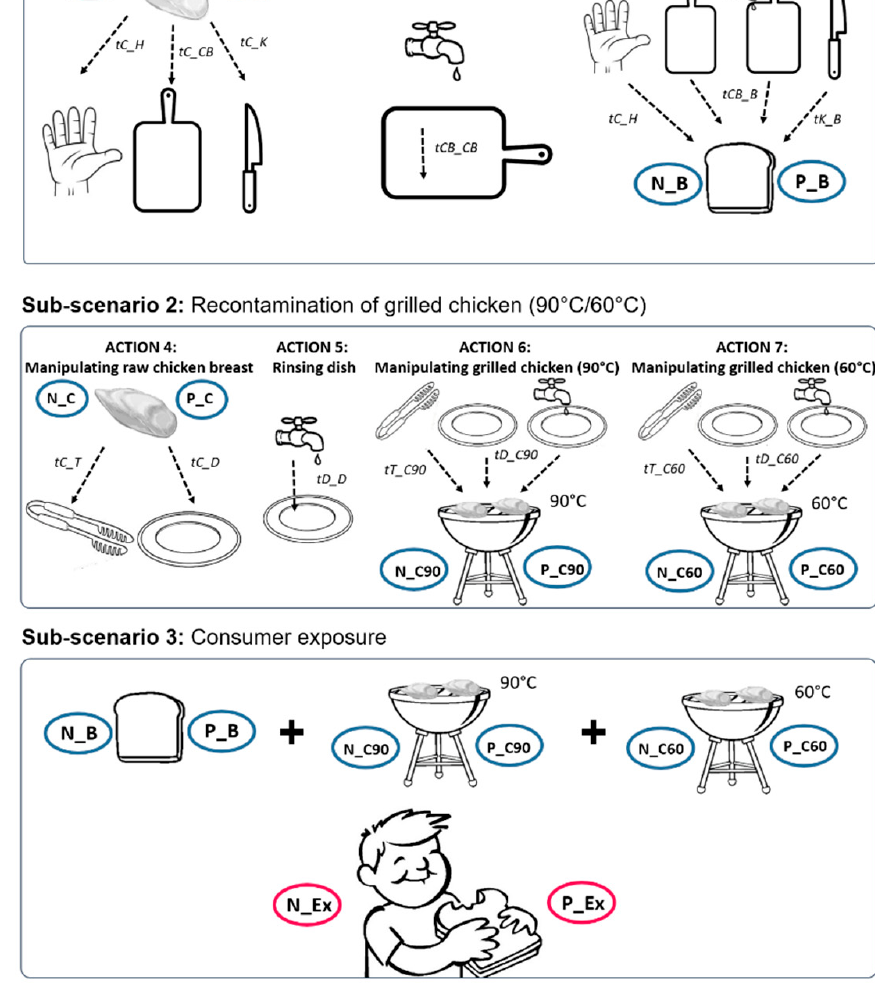
Figure 1. Detailed description of the contemplated scenario and sub-scenarios, including objects,